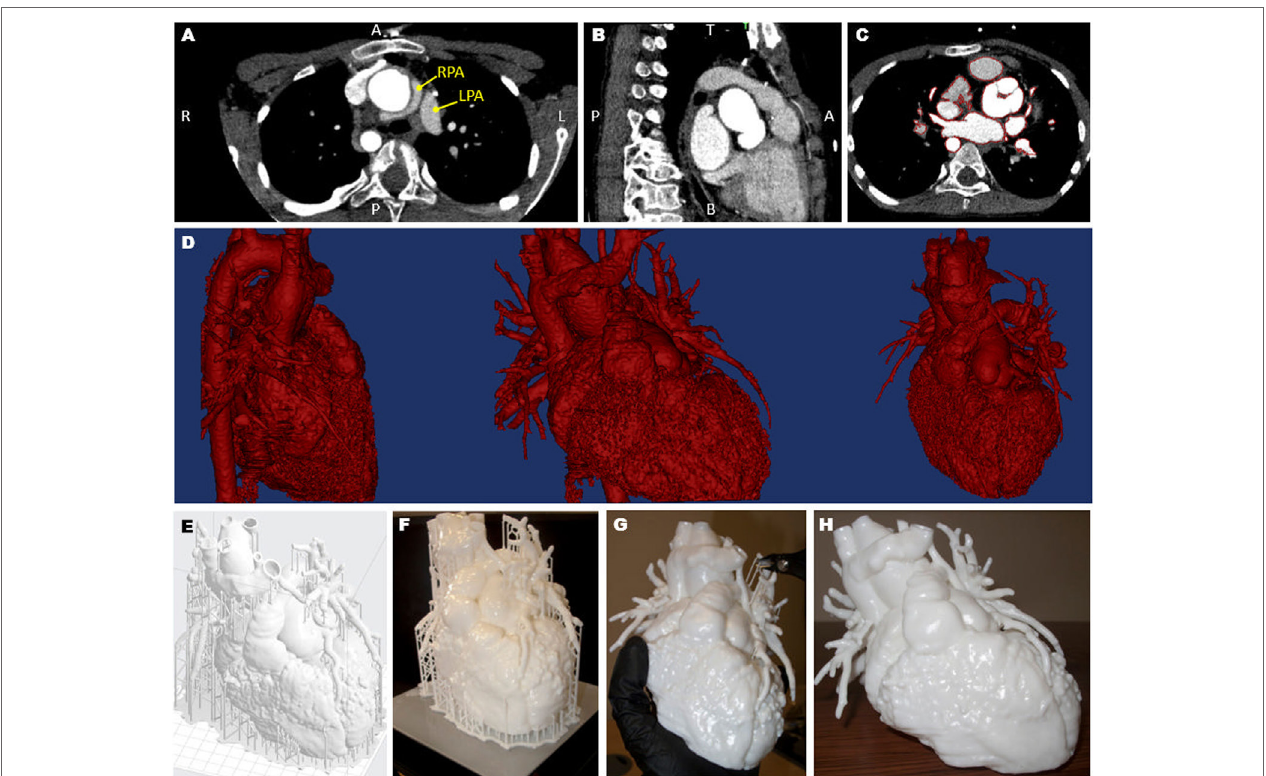
FIGURe 1 | Views of the computed tomography imaging dataset (a–C) including highlight of the position of the left and right pulmonary artery (LPA and RPA), showing the RPA wrapping around the aorta (a) ; the red outline in panel (C) shows the regions included in the three-dimensional (3D) model; the data are then rendered in 3D [ (D) , showing different views]; a scaffold (e) is built around the model prior to 3D printing (F) and the removed (G) , resulting in the final patient- specific model (H)